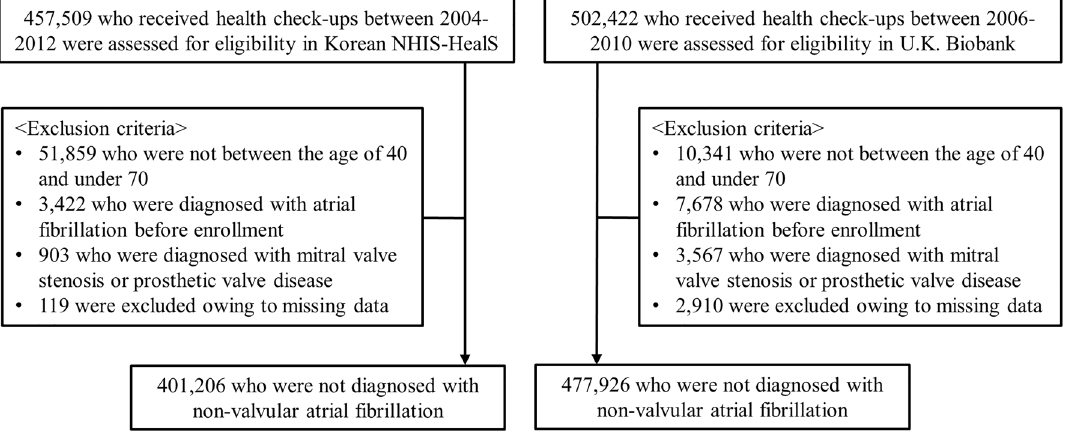
Figure 1. Flow diagram of the study population. Proportions of obese and severely obese individuals were higher in the U.K. Biobank cohort than the Korean NHIS-HealS cohort. NHIS-HealS National Health Insurance Service’s Health